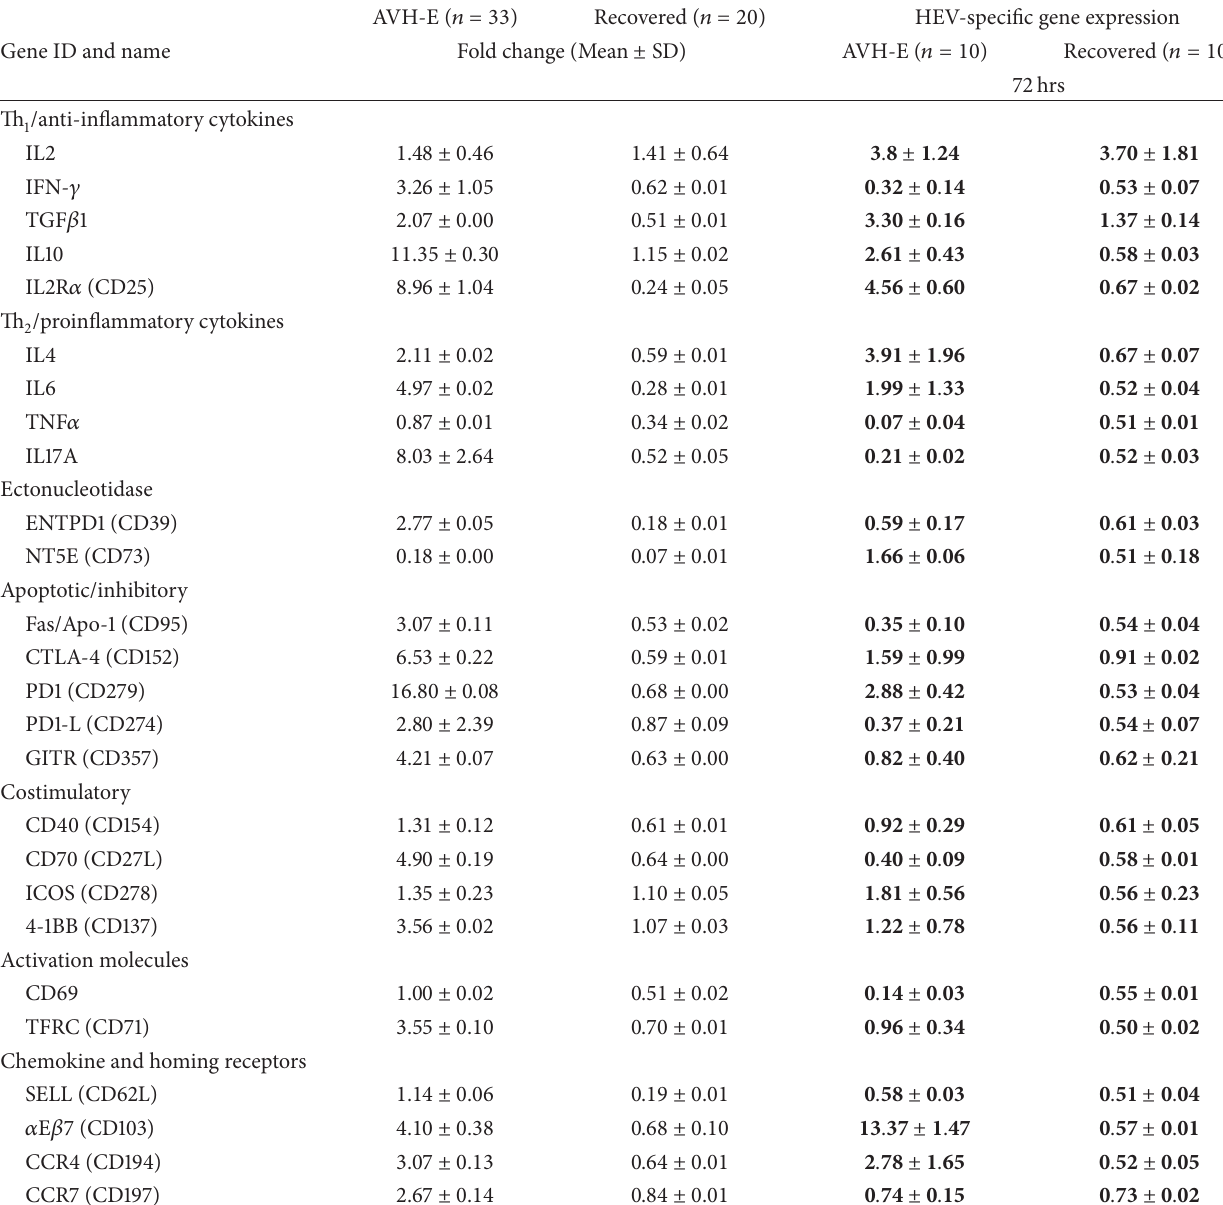
Table 2: Gene expression quantified using TaqMan Low Density Arrays and normalized with respective